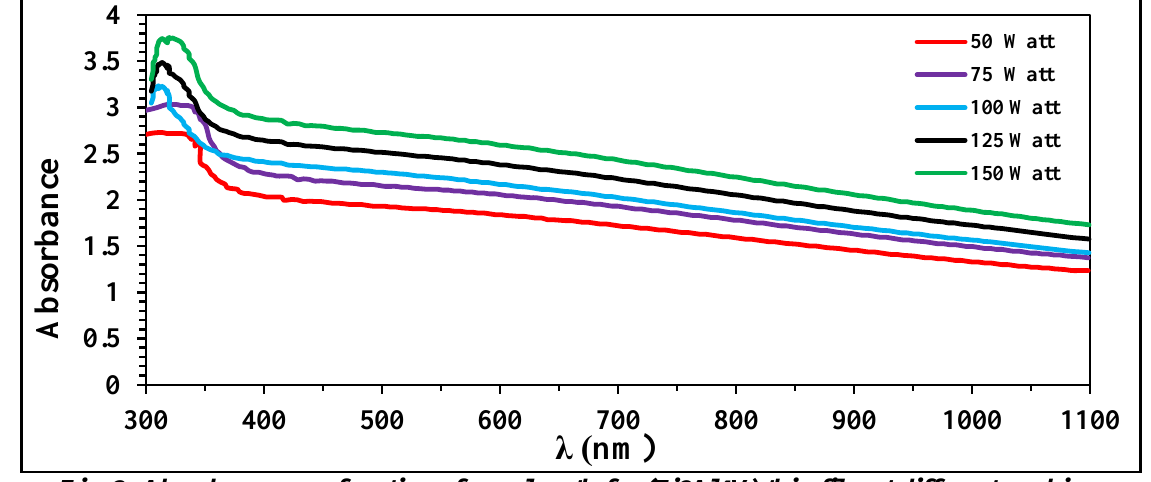
Fig. 3: Absorbance as a function of wavelength for (Ti6Al4V) thin film at different working RF powers.